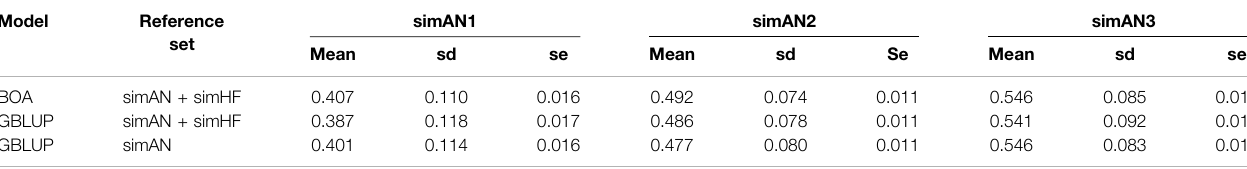
TABLE 2 | Mean accuracies of genomic prediction in the simulated breed size scenarios.